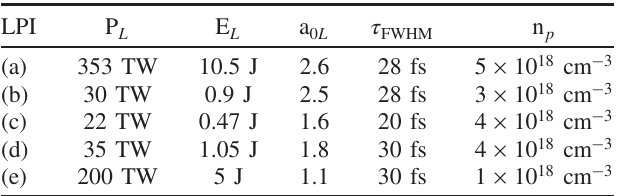
TABLE II. Laser and plasma parameters of the studied injection techniques. P L , E L , a 0 L , and τ stand for the laser pulse FWHM power, energy, strength, and duration, respectively. n p and l p stand for the plasma density and length,